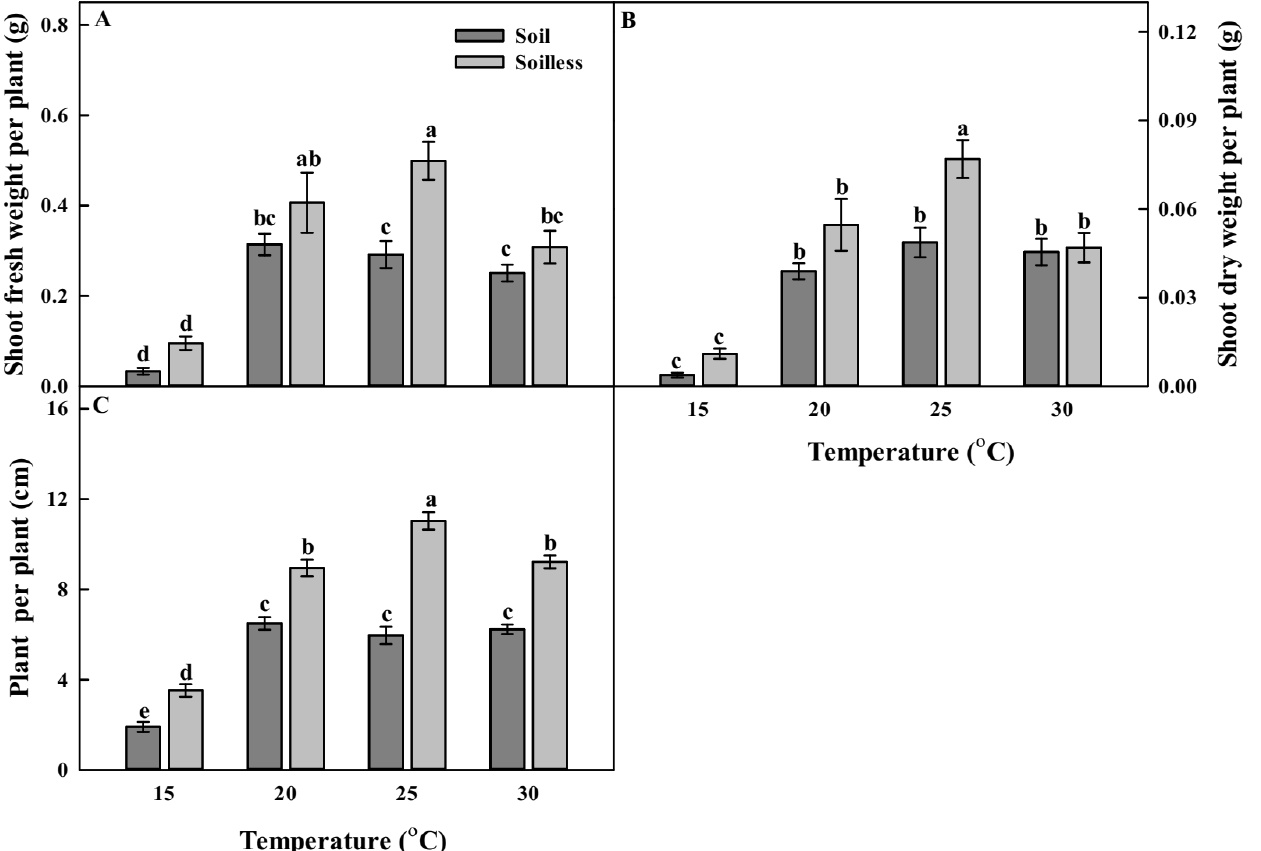
Figure 1. Shoot fresh weights ( A ); shoot dry weights ( B ); and plant heights ( C ) of balloon flower sprouts grown under soil culture and soilless culture systems with different temperatures at 17 days after transplanting. Different letters indicate significant difference at p < 0.05 ( n =